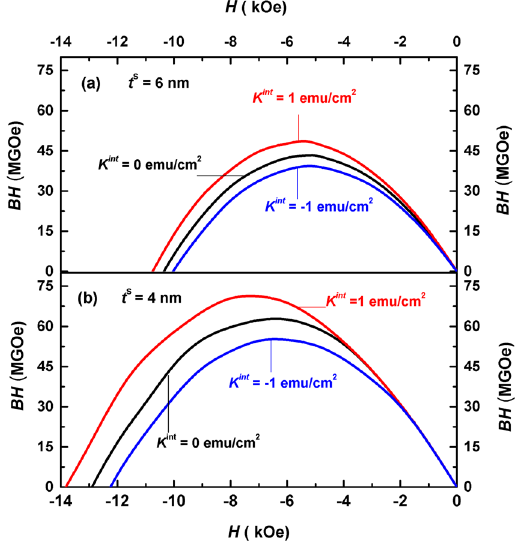
Figure 7. Calculated magnetic energy products ( BH ) of Nd 2 Fe 14 B (10 nm)/ α -Fe ( t s ) multilayers for various interface anisotropy. ( a ) Energy products for soft layer thickness t s = 6 nm. ( b ) energy products for t s = 4